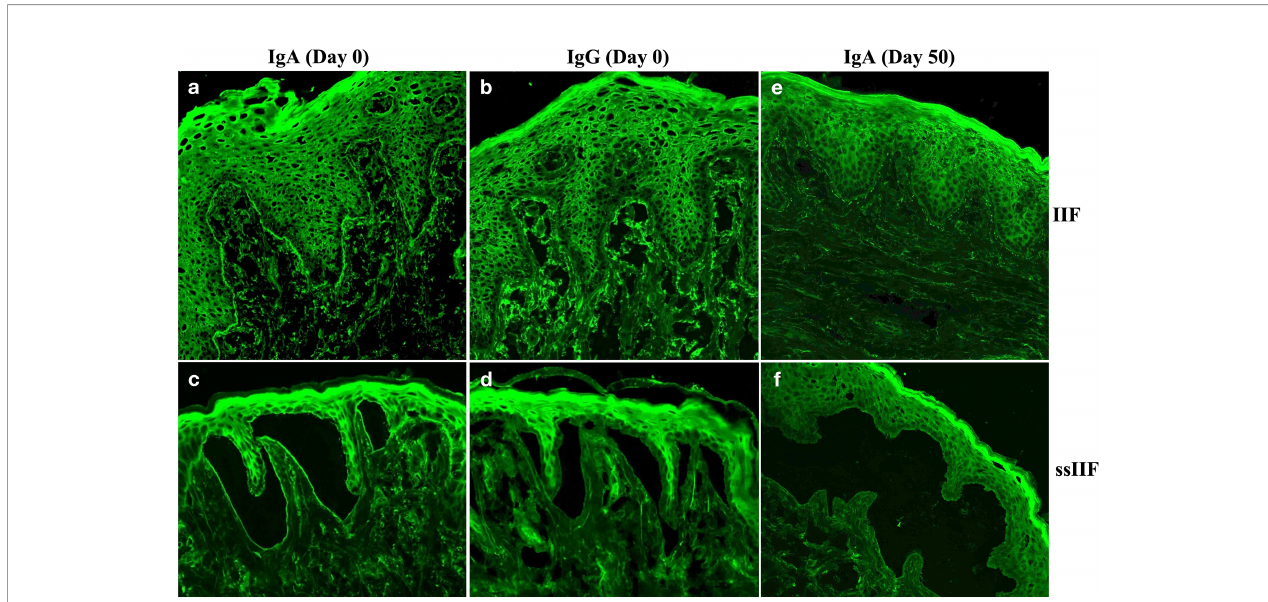
FIGURE 3 | Indirect immuno fl uorescence using normal human skin (IIF) and using 1M NaCl-split normal human skin (ssIIF) for the patient serum taken at Day 0 and Day 50. IgA (A) , but not IgG of (B) , anti-BMZ antibodies were detected in IIF for serum taken at Day 0. IgA (C) , but not IgG (D) antibodies bound to the dermal side of the split in ssIIF for serum taken at Day 0. IgA antibodies were not detected in both IIF (E) and ssIIF (F) for serum taken at Day